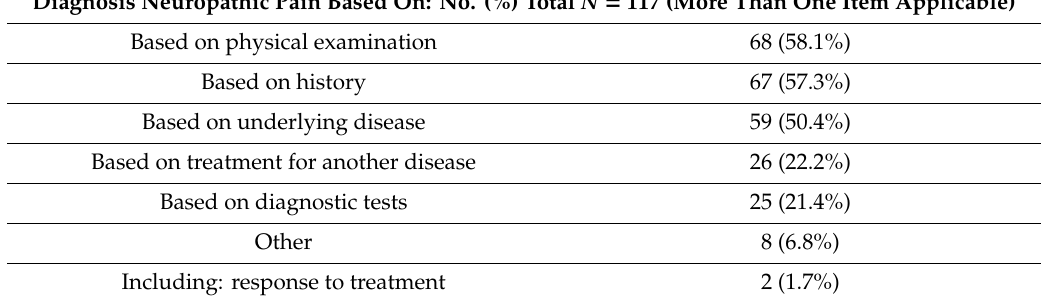
Table 3. Condition on which practitioners base the diagnosis of neuropathic